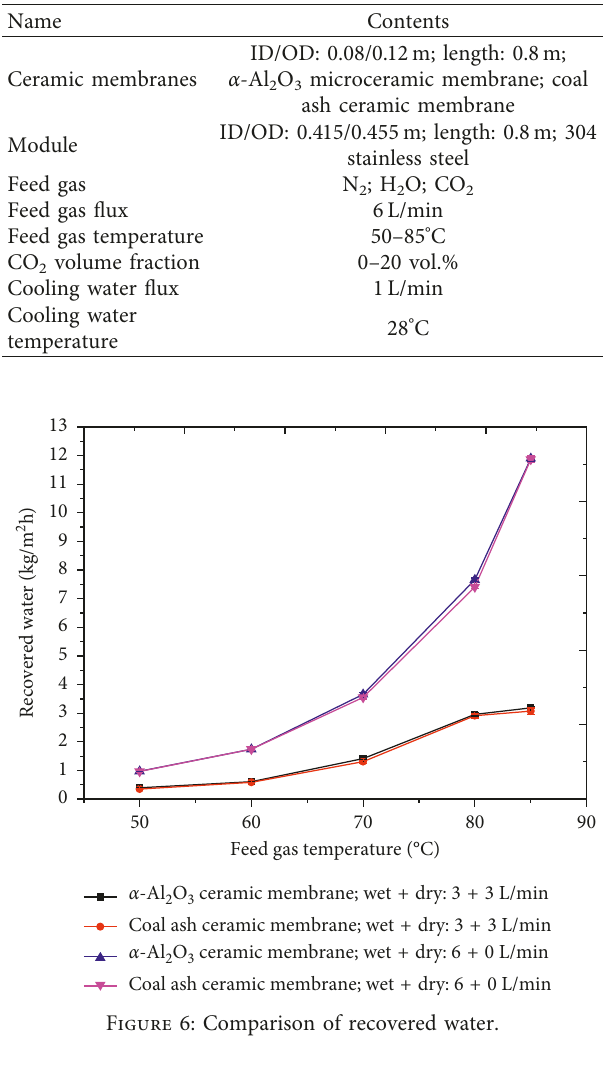
Figure 6: Comparison of recovered water.